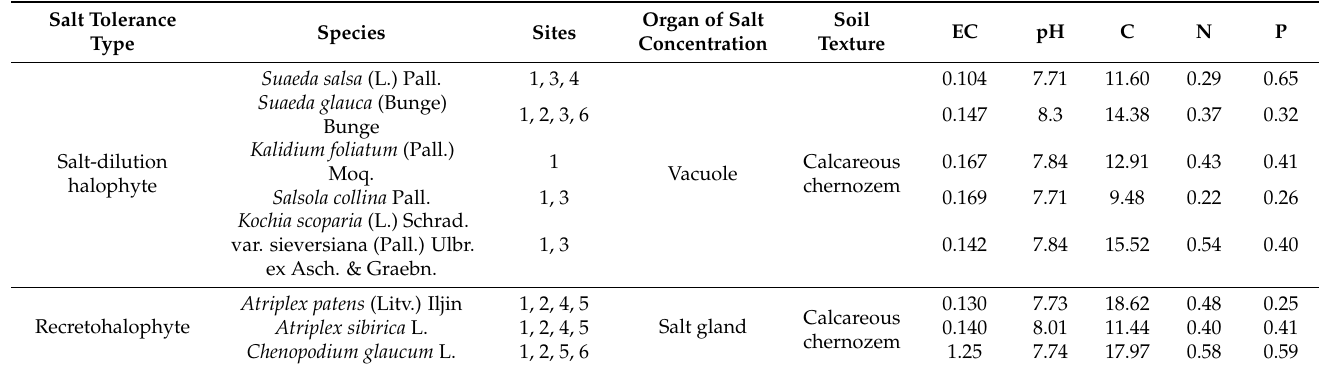
Table 5. The physical, chemical and biological properties of plants belong to Chenopodiaceae family (i.e., soil texture, EC, pH, organic carbon, total nitrogen and total phosphorus). Salt Tolerance